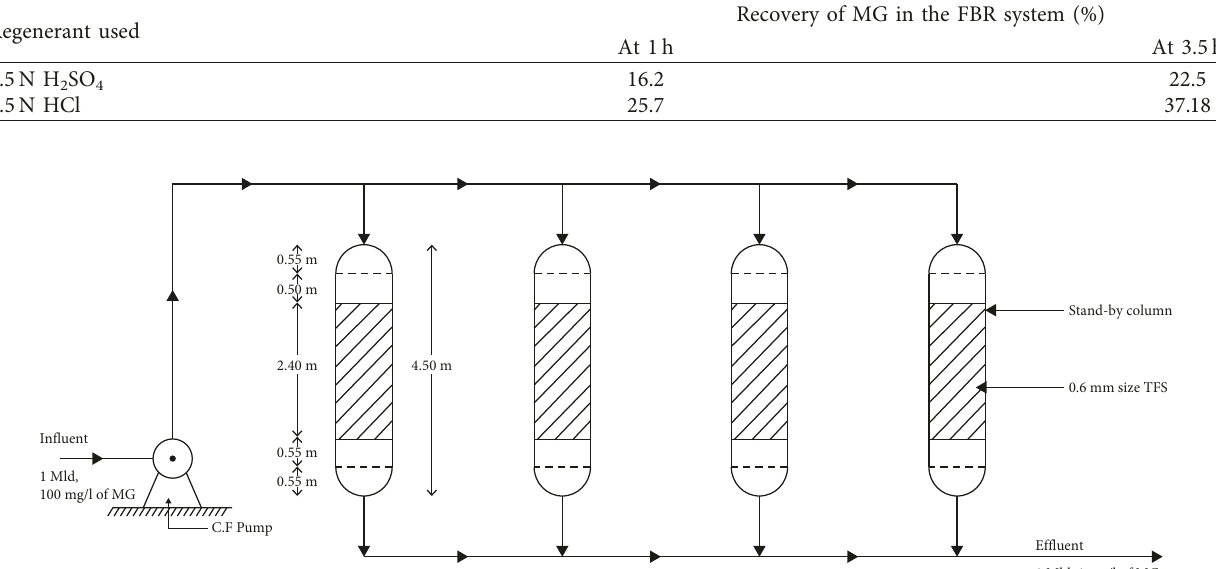
Figure 9: Scale-up set